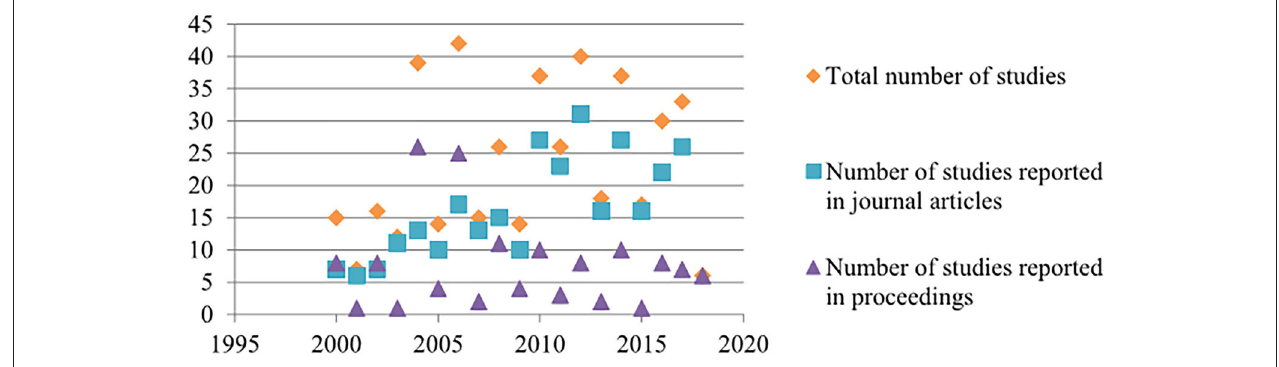
FIGURE 2 | Annual number of included studies by study type from journal articles from 2000 to 2017 and proceedings from 2000 to